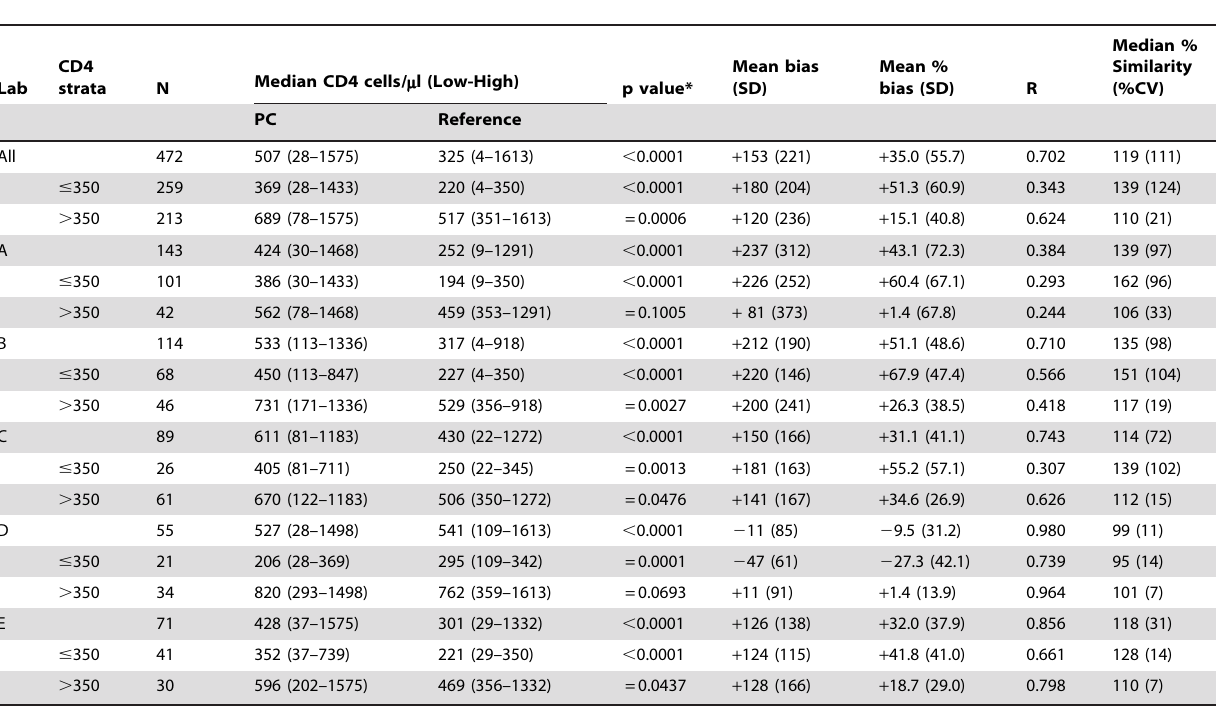
Table 2. Bias between reference method and PointCare Now (PC) for CD4 absolute